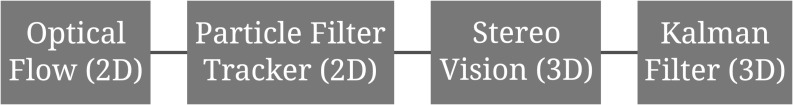
Tracking of generic objects.See text for details.